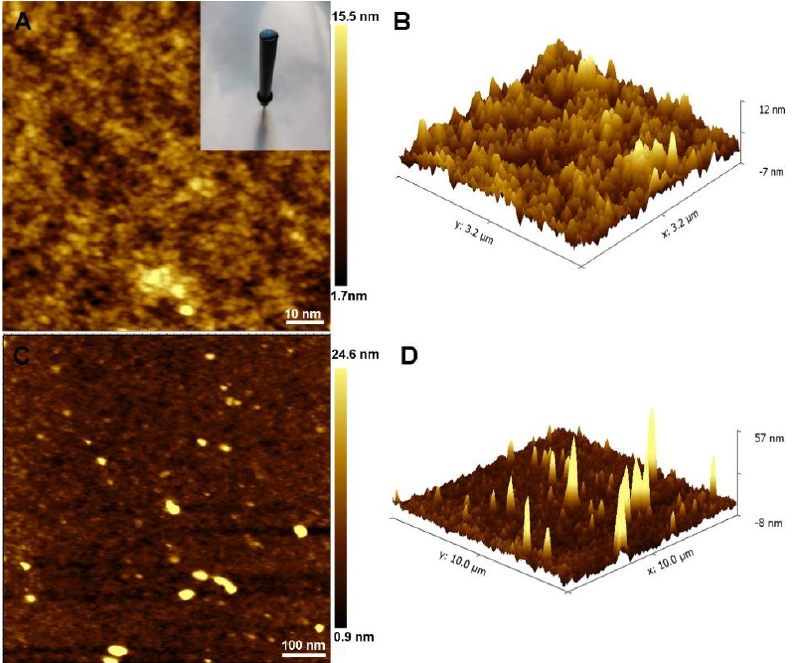
Figure 1. Two-dimensional planar AFM images of PEDOT:PSS ( A ), the picture inset in ( A ) dis- plays a photograph of PEDOT:PSS modified to the GCE surface. Three-dimensional AFM images of PEDOT:PSS ( B ), two-dimensional planar AFM images of AuNPs/PEDOT:PSS ( C ), and three- dimensional AFM images of AuNPs/PEDOT:PSS ( D